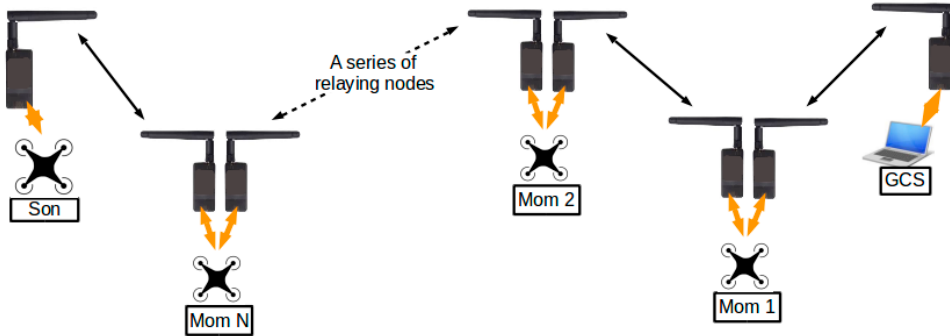
Figure 23. Extending the relay system by adding relaying nodes.